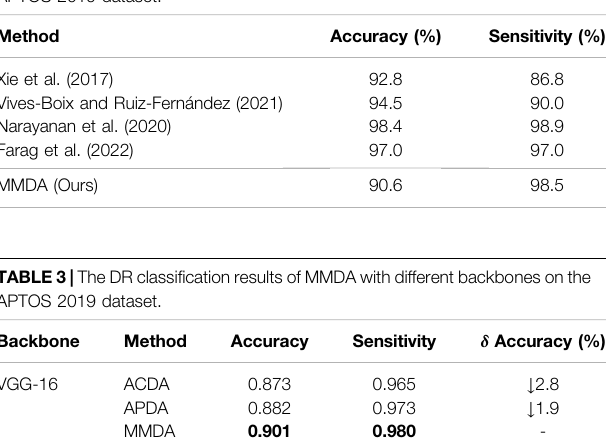
TABLE 2 | Accuracy and sensitivity of MMDA for diabetic retinopathy diagnosis compared with state-of-the-art supervised learning approaches on the APTOS 2019